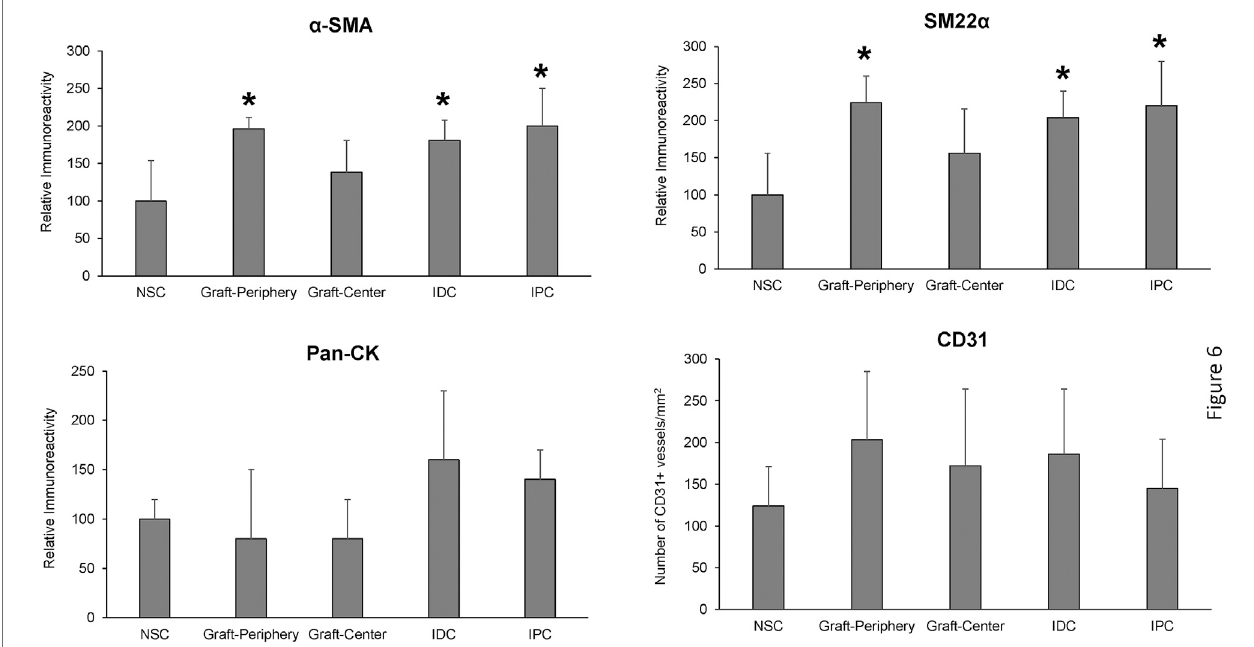
FIGURE6|Histomorphometricevaluationsoftissue-speci fi cproteinsinneoconduitsandcontrolgroups. Quantitativeanalysesofmarkerexpressionin neotissue regions at 12 weeks post-op and control cohorts following immunohistochemical staining. Values are presented as means ± SD. NSC, nonsurgical controls; IPC, internal proximal controls; IDC, internal distal controls. Results from all groups were analyzed with Kruskal – Wallis and post hoc Dunn ’ s tests. * p < 0.05 relative to respective NSC levels. N (cid:1) 5 samples per data point from all swine.